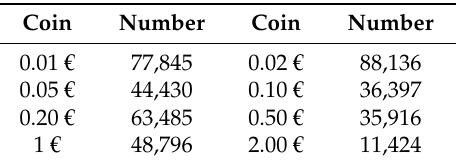
Table 2. Number of coins per